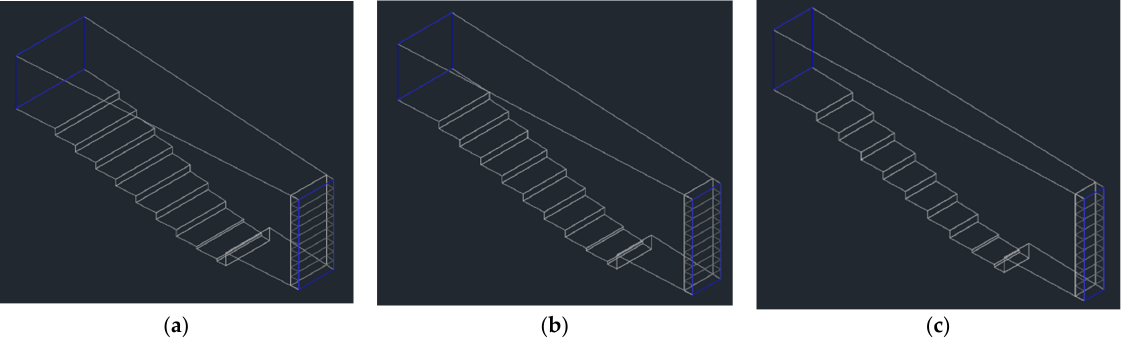
Figure 8. Scheme of the auditorium construction methodology, using a two-dimensional horizontal section. ( a ) Case D, ( b ) Case E, and ( c ) Case F.